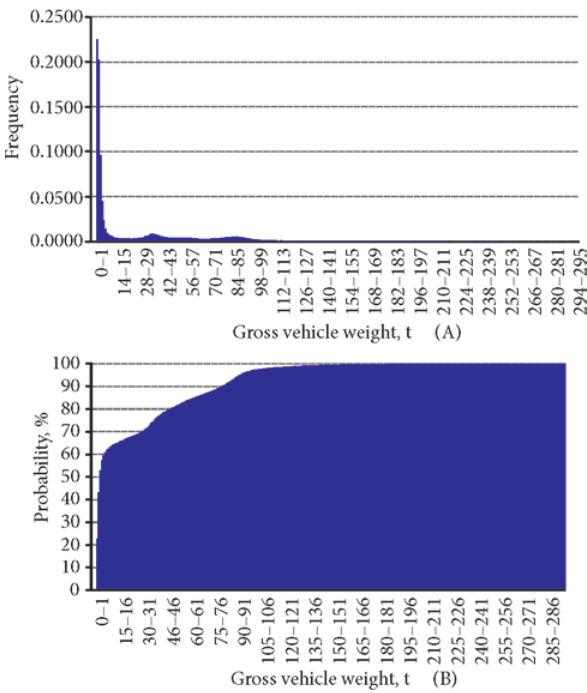
Fig. 2. Vehicle gross weight frequency distribution (A) and the accumulative probability distribution (B)